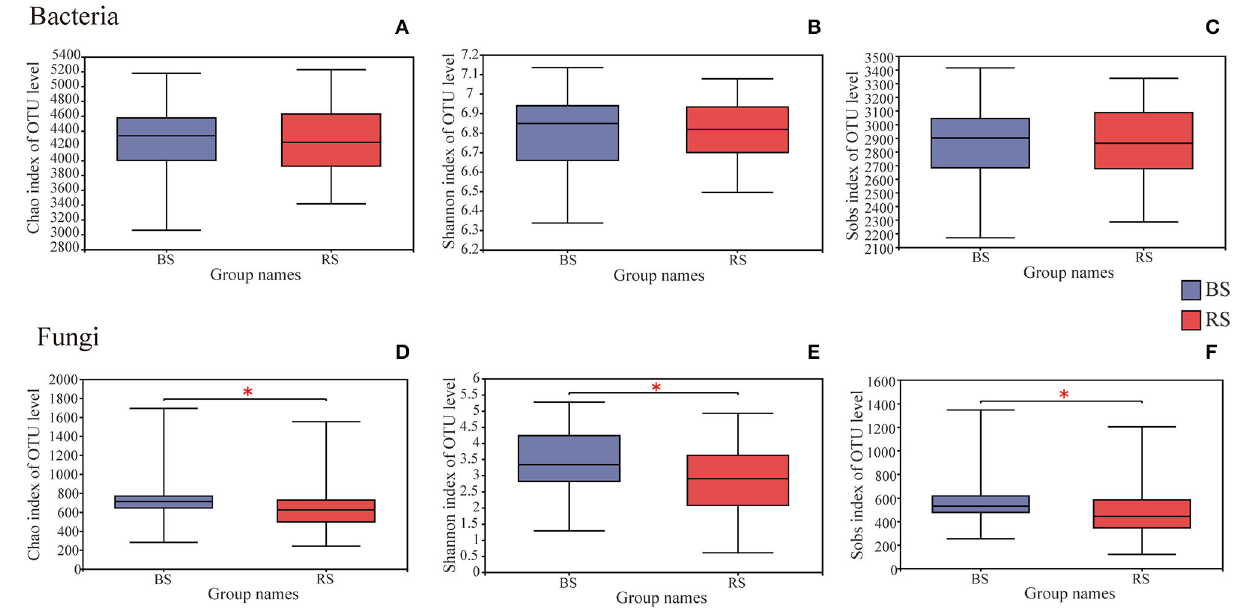
FIGURE 1 | Differences in bacterial (A–C) and fungal (D–F) α -diversity indexes in the rhizosphere and bulk soils. The height and position of boxes were determined by upper and lower quartiles. The horizontal line inside boxes shows the median, while the outside top and bottom ones show the maximum and minimum values, respectively. *Indicates significant differences between two groups, P < 0.05. BS and RS represent the bulk soil and the rhizosphere soil,